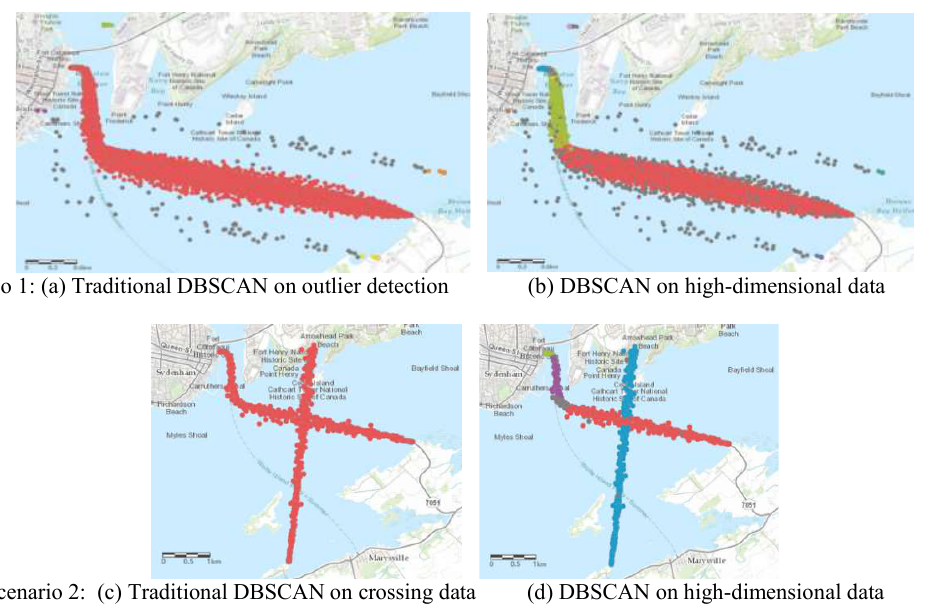
Figure 2. Comparison result of DBSCAN on high dimensional geospatial data